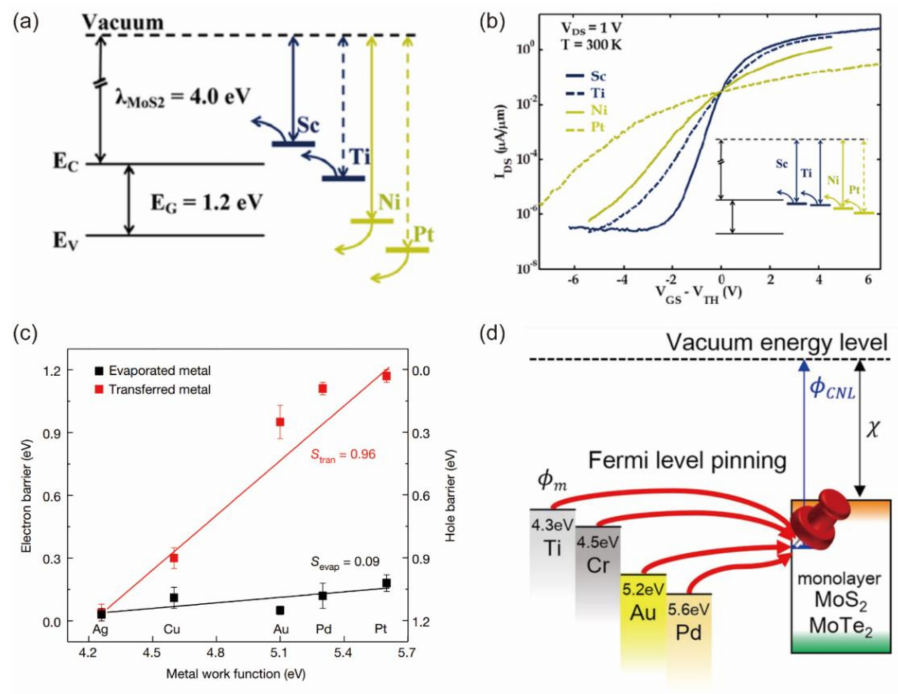
Figure 1. Origin and influence of Fermi-level pinning. ( a ) Expected metal Fermi level with the electronic bands of MoS 2 and different metal electrodes with different work function. ( b ) Transfer curves with different metals. The inset shows the actual line-up based on the experimental data. Reprinted/adapted with permission from Ref. [26]. Copyright 2012, American Chemical Society. ( c ) Experimentally determined Schottky barrier height for transfer of different transfer metals